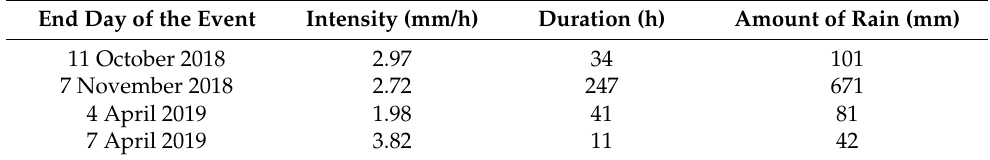
Table 5. Rainfall events associated with minor